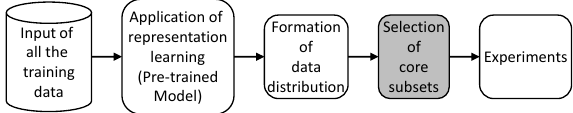
Figure 2. Research architecture.